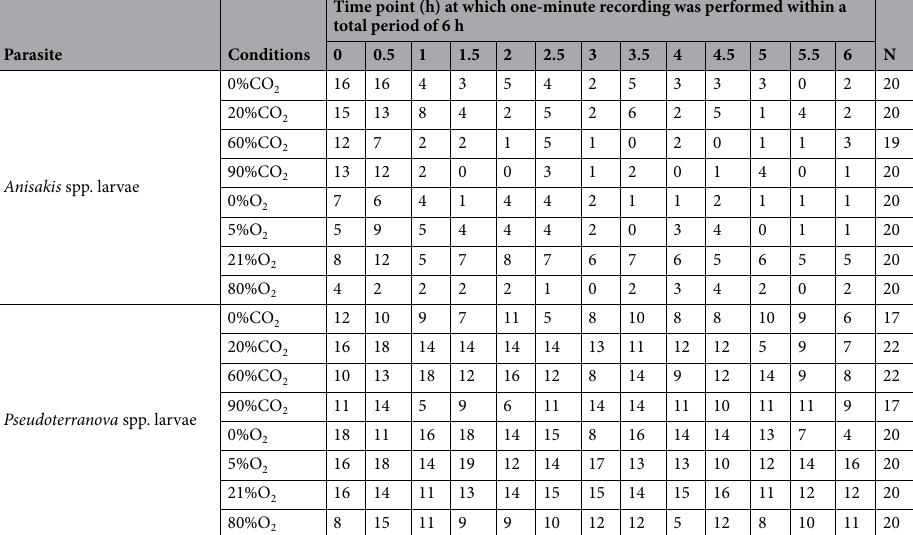
Table 2. Number of larvae that were motile in 1-min recordings every half hour during 6 h. N total number of larvae analyzed (excluding ineligible larvae). 1-min recordings were taken every 30 min for 6 h at different conditions of CO 2 and O 2 experiments at 6 ℃